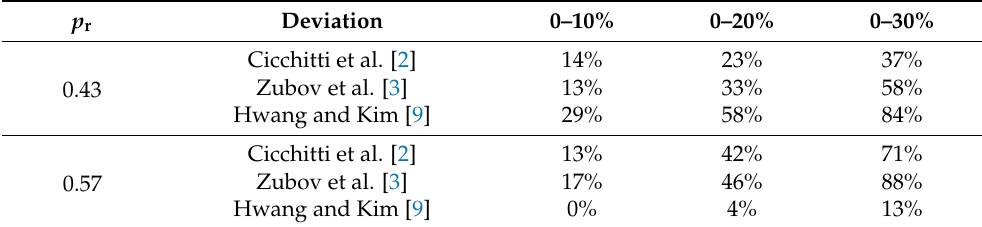
Table 3. Comparison of obtained pressure drop databases with predictions of selected correlation.